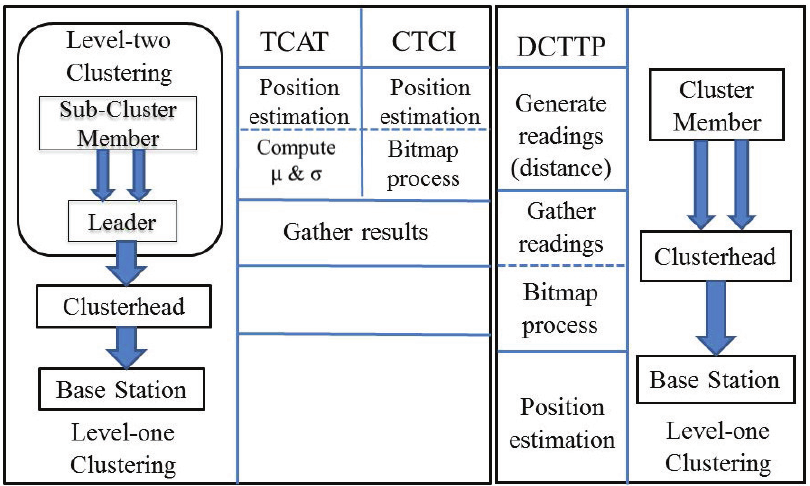
Figure 2. The information processing model of Two-level Clustering Approach via Timer (TCAT) ( left ), Cooperative Tracking via Compressing Information (CTCI) ( middle ) and DCTTP ( right